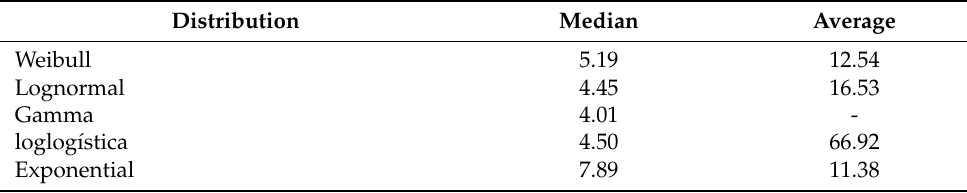
Table 1. Marginal provisions payable ( €